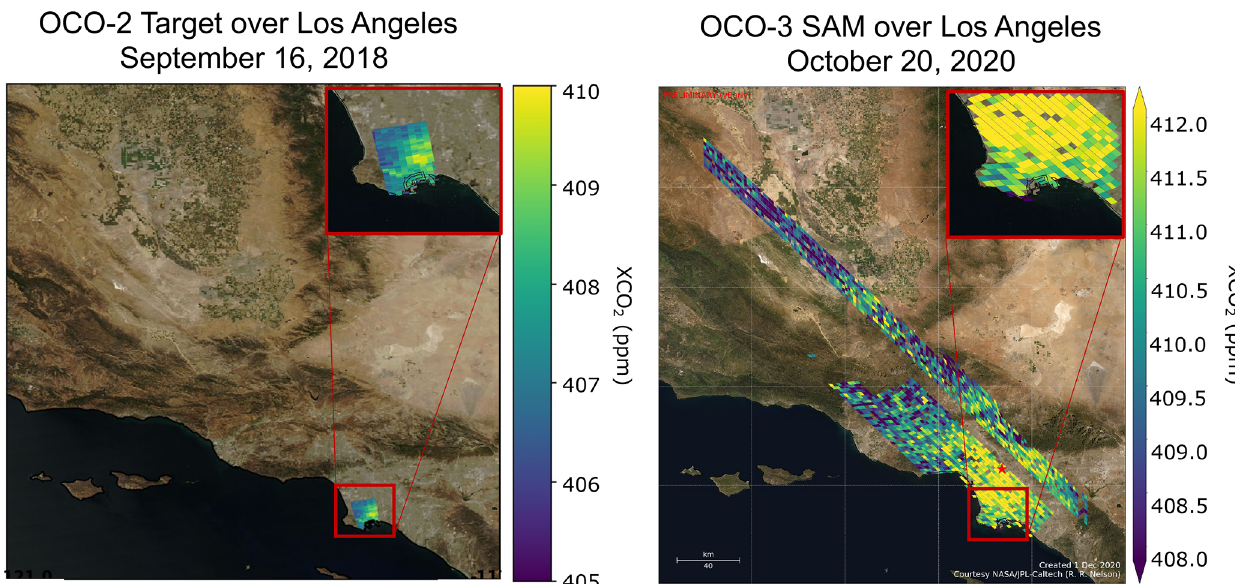
Figure 3. Visual comparison of target and SAM mode observations over the LA basin. The left panel and insets were generated by overlaying OCO-3 data on RGB images from NASA Worldview (Cronk et al., 2023).